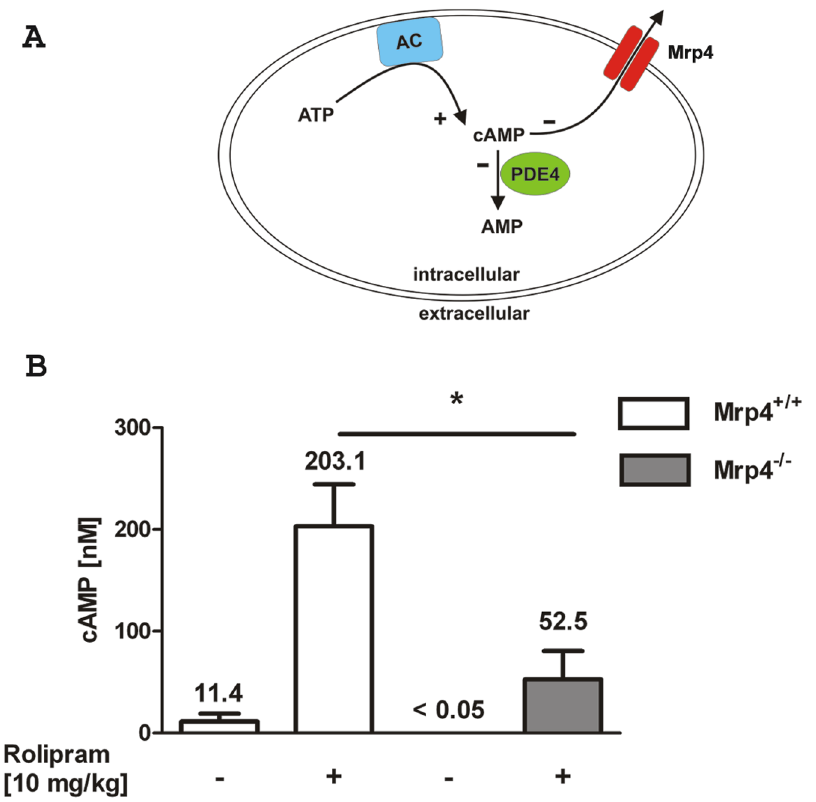
Figure 6. Mrp4 is involved in the control of plasma cAMP concentration after oral application of Rolipram. A) Simplified schematic of the intracellular cAMP regulation. The adenylyl cyclase (AC) catalyses the generation ( + ) of cAMP from ATP. cAMP is hydrolyzed ( 2 ) to inactive AMP by the activity of PDE4. Mrp4 is able to pump cAMP out of the cells ( 2 ). The inhibition of PDE4 as well as Mrp4 has the potential to increase intracellular cAMP levels. B) Rolipram ( + ; 10 mg/kg) or vehicle for control ( 2 ) was given orally to Mrp4 2 / 2 mice (grey bars) or Mrp4 + / + mice (open bars). After 20 min blood samples were collected retro-bulbar to measure plasma cAMP concentrations. Control groups n=3, Rolipram treated groups n=5. * p=0.02. Data are mean 6